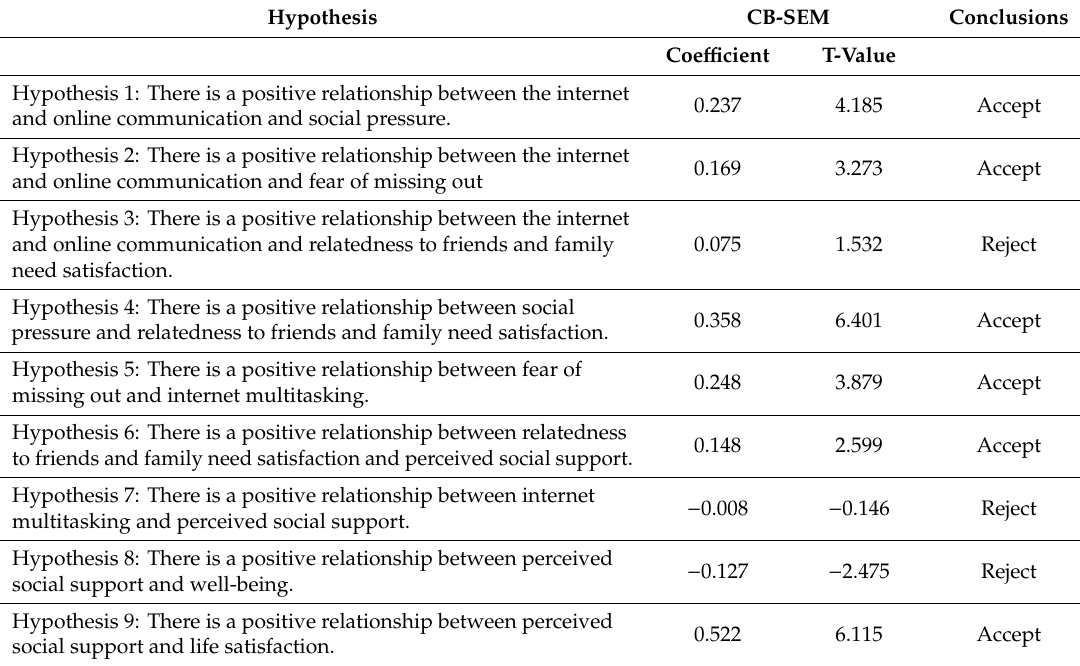
Table 2. Test of